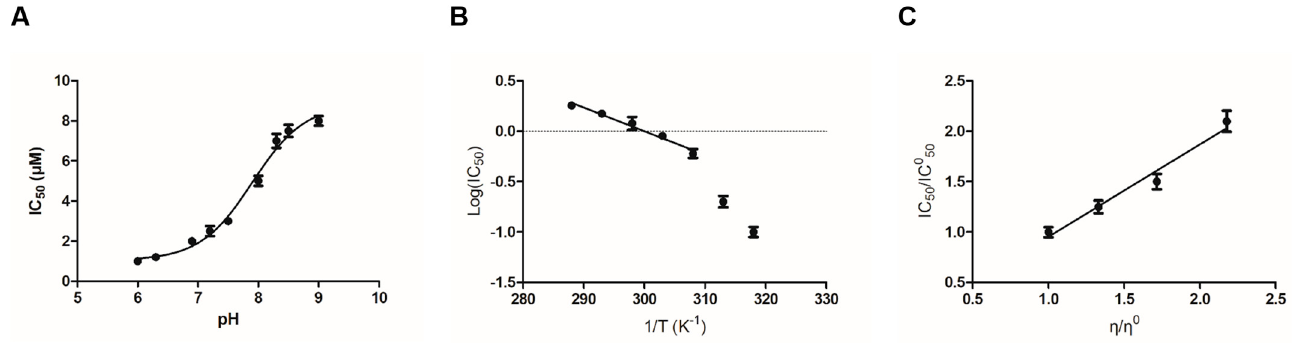
Figure 4. Dependence of IC 50 ( μΜ ) on pH ( A ), temperature ( B ) and viscosity ( C ).